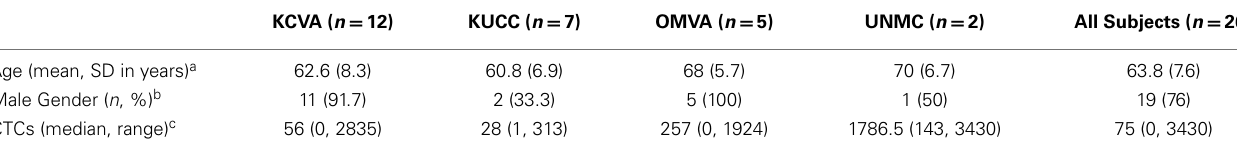
Table 1 | Baseline characteristics .